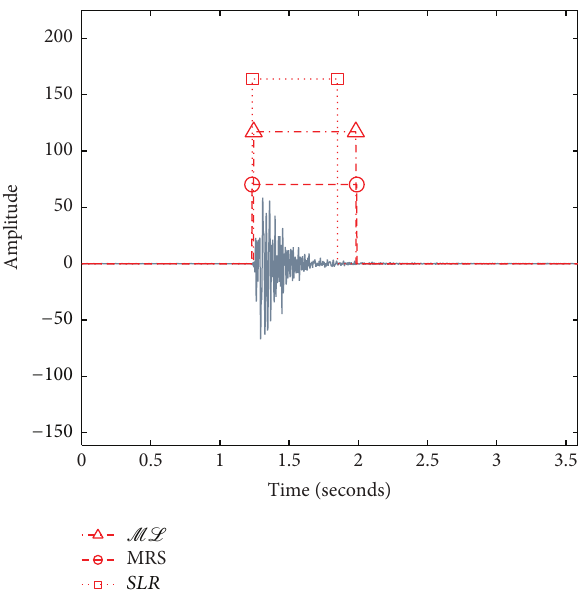
Figure 13: The comparison of the discussed segmentation methods applied to the real data consisting of a single seismic